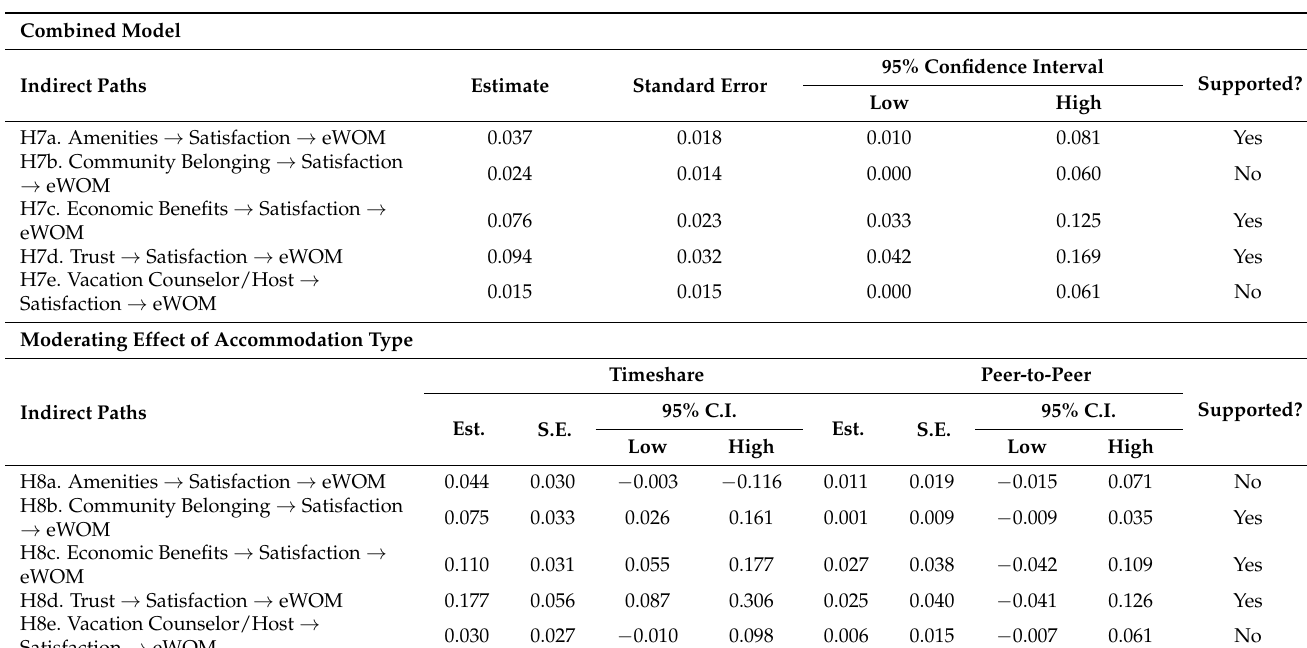
Table 5. Parameter estimates for indirect effect of